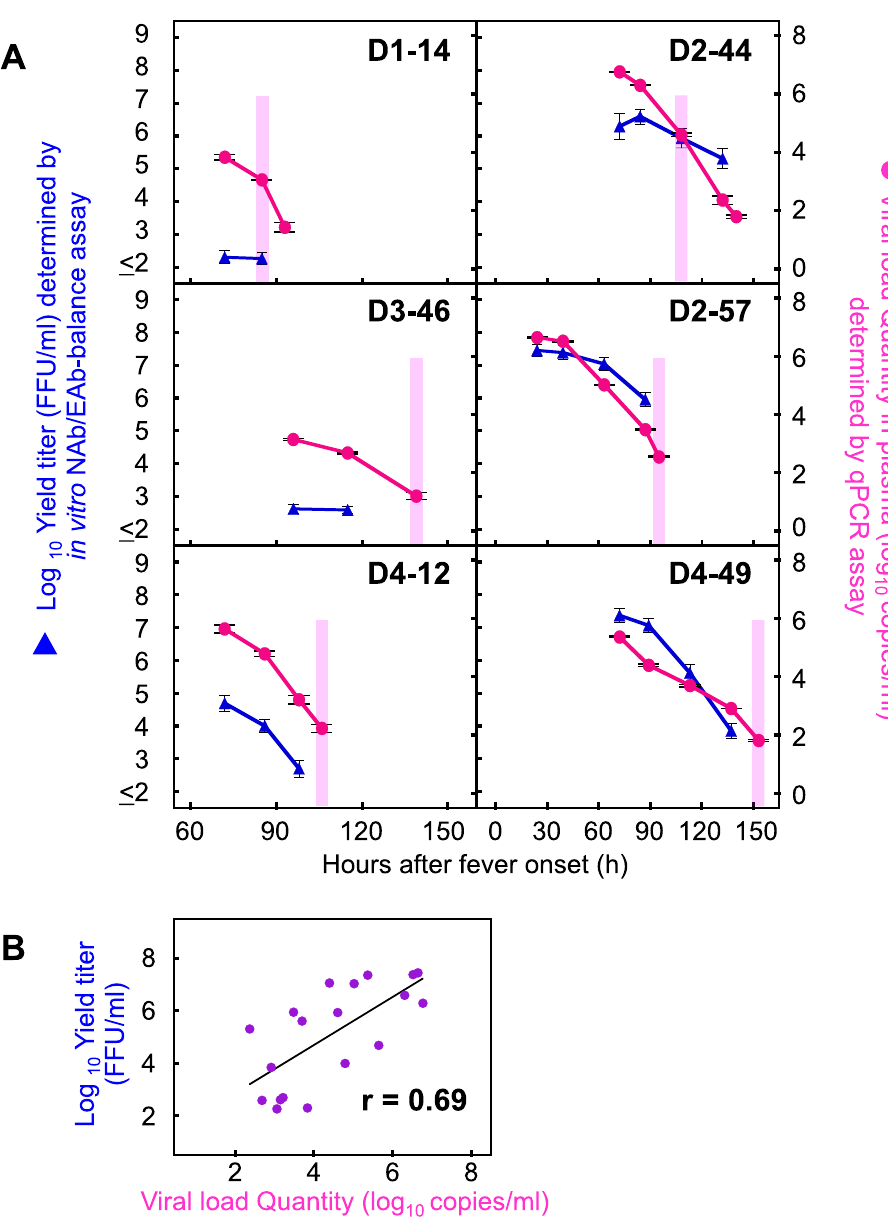
Figure 4. Relationship between in vitro ADE activity and in vivo viral load quantity. ( A ) The NAb/EAb-balance assay was conducted with a combination of serum diluted at 1:10 and the corresponding autologous virus. Culture supernatants were harvested at 24 h after the mixture of serum, virus and K562 cells. The infective titers were determined on Vero cells and plotted as the left ordinates ( blue triangles : expressed as log10 FFU/ml). The number of viral RNA copies in plasma samples collected at same time points as well as one extra time point (D1- 14: 93 h, D2-44: 140 h, D3-46: 139 h, D2-57: 95 h, D4-12: 106 h and D4-49: 153 h) were determined by real time RT-PCR, and plotted as the right ordinates ( red circles : expressed as log10 copies/ml). The abscissae indicate time (h) after fever onset. Pink shading indicates the beginning of defervescence on the clinical observation. ( B ) Correlation between the ADE progeny virus titers and the viral RNA copy numbers. The correlation coefficient (r) was estimated for the individual progeny virus titers and qPCR values obtained in Fig. 4A (however, following samples were excluded; D1-14: 93 h, D2-44: 140 h, D3-46: 139 h, D2-57: 95 h, D4-12: 106 h and D4-49: 153 h). The abscissa and ordinate indicate the qPCR values and the progeny virus titers, respectively. Linear regression lines and r values are presented in the